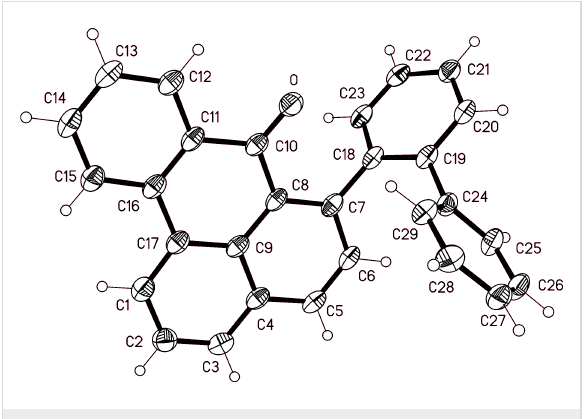
Figure 2: Ellipsoid representation (50% level) of compound 7 in the crystal.